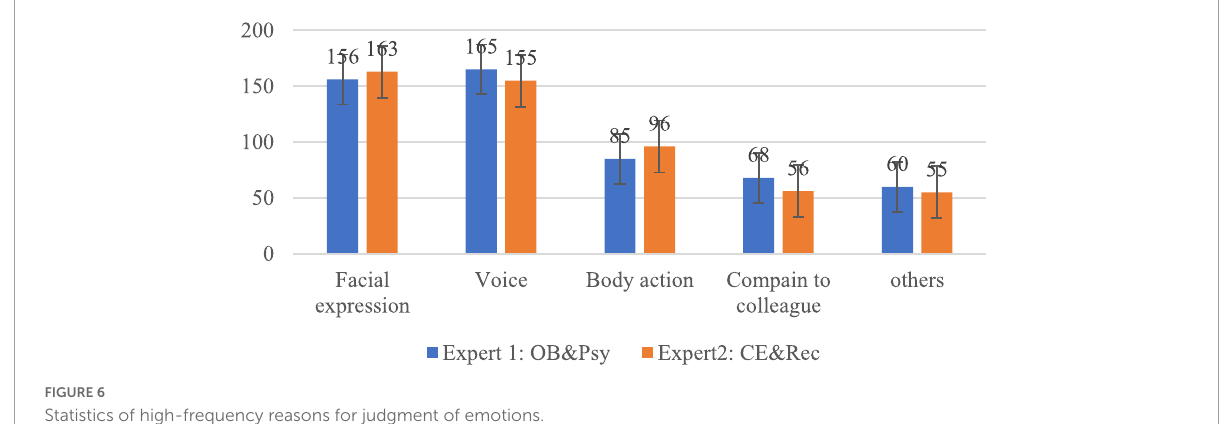
FIGURE6 Statistics of high-frequency reasons for judgment of